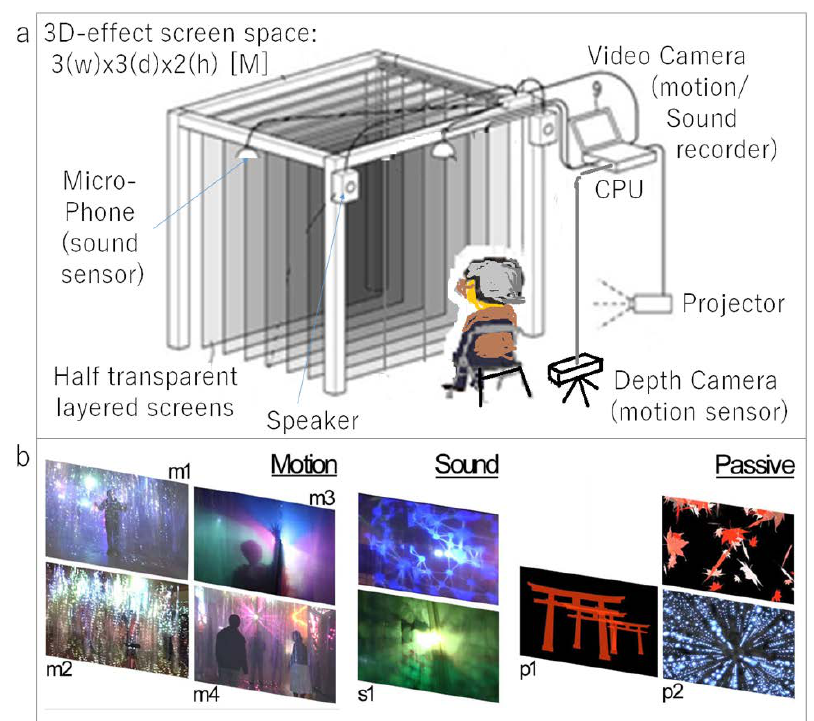
Figure 1. The set structure and digital art installation scenes: ( a ) One to four subjects participated in the digital art entertainment installment at a time. During participation, motion of each subject was recorded by depth camera placed behind the subjects, and sound was recorded by a microphone placed in front of the subjects. The interactive art projection in the 3D-effect screen space was controlled by CPU. ( b ) Nine digital image/sound sub-works were categorized into three scene types with associated subject activity sensing: ‘motion’ tracked by a depth camera, ‘sound’ assessed by microphone, both of which function to induce the participants to move their body and speak to alter the digital art work image and sound (a supplemental file), as ‘active’ responses. ‘Passive’ scenes were presented without any subject sensing and no activity-dependent image/sound alteration. Projected output example photos include human motion-dependent images (m1–m4), sound-dependent images (s1) and original images without sensor function (p1, p2).